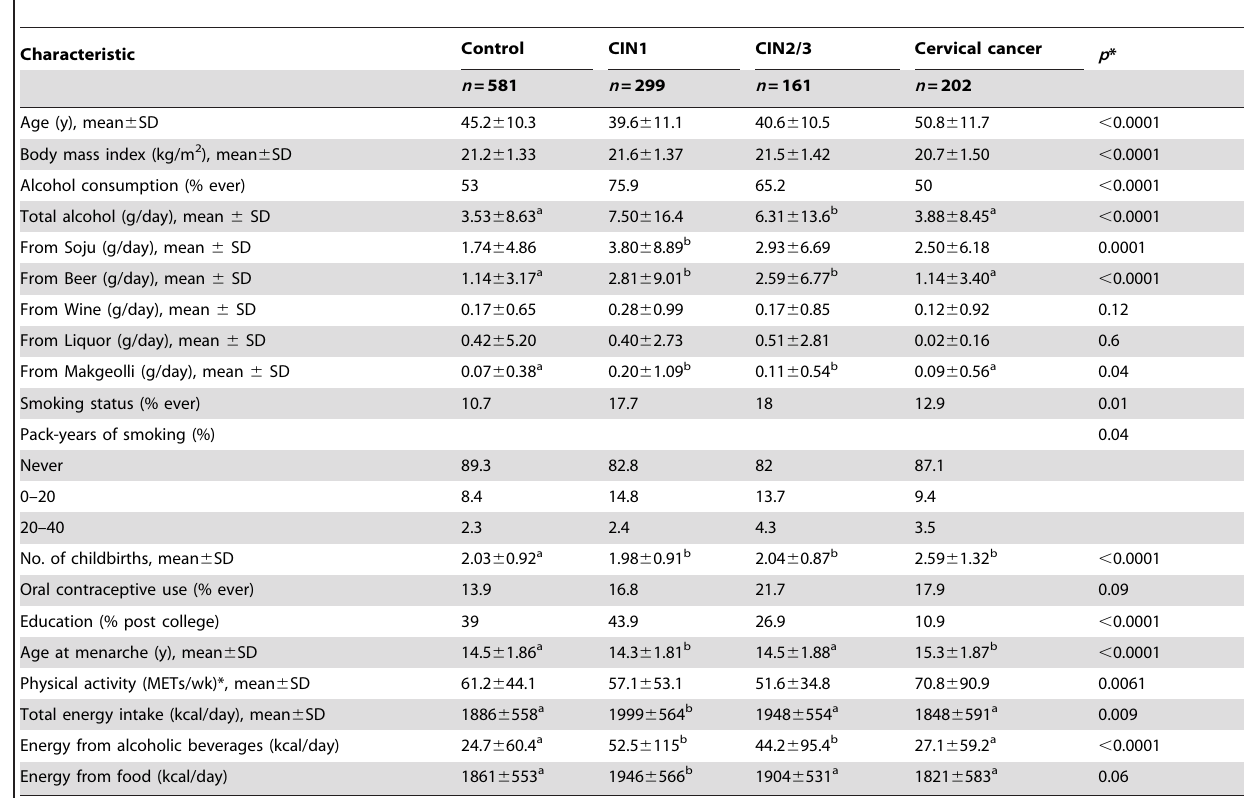
Table 1. Sociodemographic, reproductive, anthropometric, and lifestyle characteristics of study